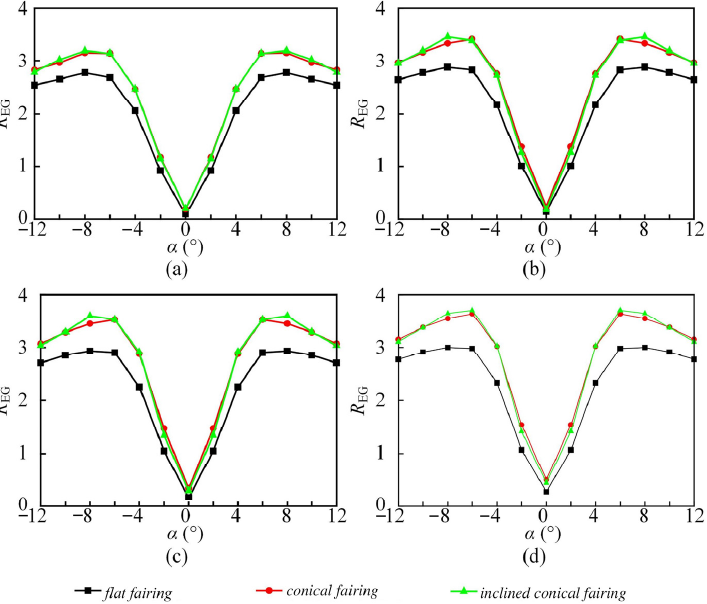
Figure 7. The lift-resistance ratio and angle of attack of the vehicle with different fairings of the thermal energy power generation module under different speed conditions ( a ) v m = 0.1 m/s; ( b ) v m =